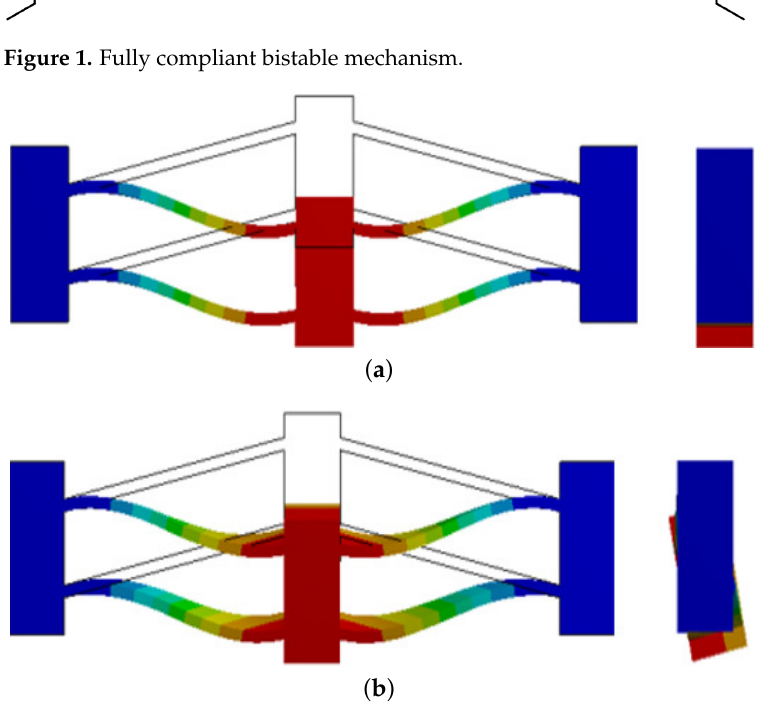
Figure 2. ( a ) Compliant bistable mechanism deflection unaffected by off-axis or eccentric load; ( b ) Compliant bistable mechanism deflection affected by off-axis or eccentric